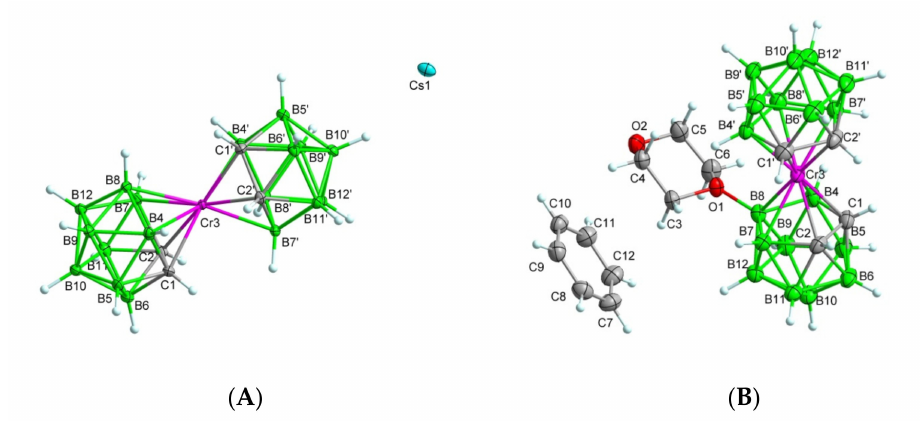
Figure 13. The x-ray structures of the parent chromium sandwich 3 ( A ) and the dioxane derivative 7 · C 6 H 6 ( B ). Displacement ellipsoids are drawn at the 50% probability level. Selected interatomic distances [Å] and angles [ ◦ ] are: ( A ) compound 3 ,